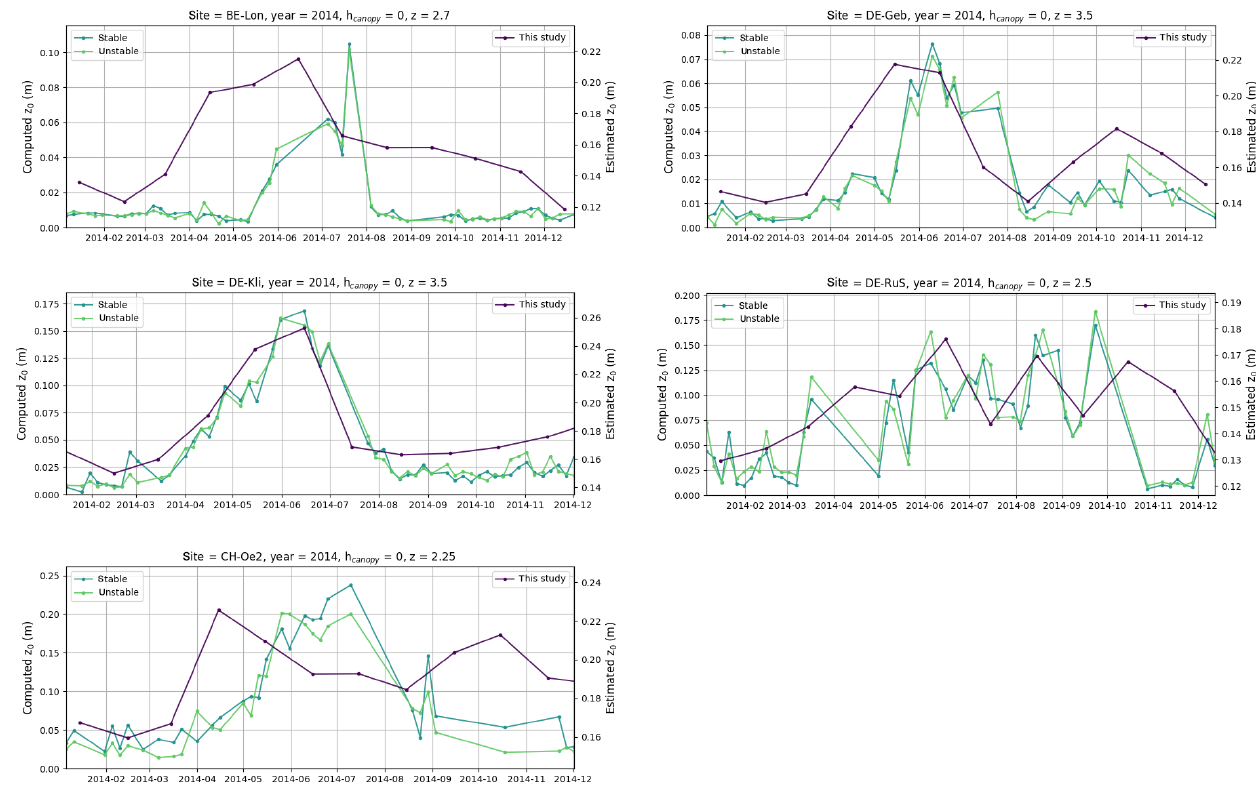
Figure 5. Seasonal variation of the computed z 0 values at the FLUXNET cropland sites in 2014 (left axis) and the corresponding z 0 values estimated from NDVI values (right axis). The green lines indicate the estimated z 0 values derived from FLUXNET measurements and the purple lines indicate the z 0 values derived from NDVI values. The assumptions used to compute the z 0 values are shown in the titles of the figures.